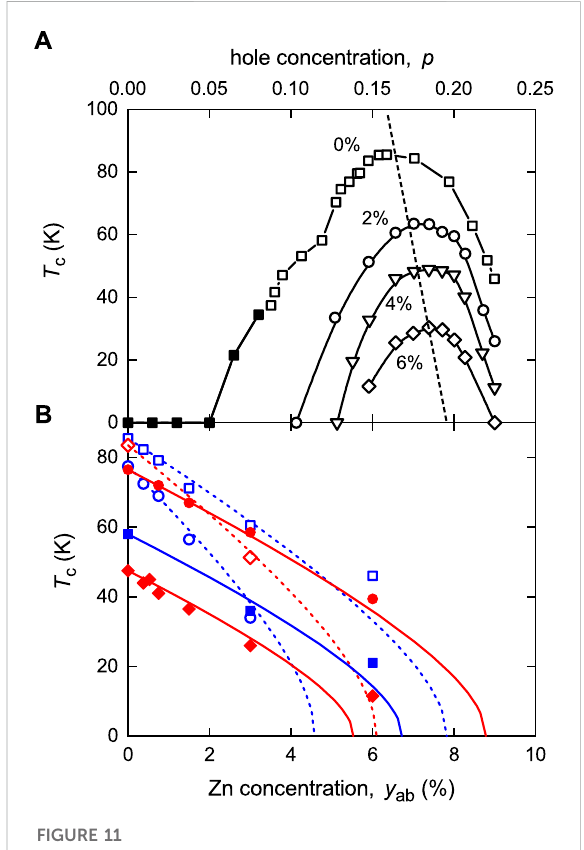
FIGURE 11 (A) T c plotted as a function of hole concentration, p , for Zn- substituted Y 0.8 Ca 0.2 Ba 2 (Cu,Zn) 3 O 7 − δ at 4 different Zn concentrations: 0%, 2%, 4%, and 6%. The dashed line is a guide to the eye showing the asymmetric collapse of the phase curve toward p * ≈ 0.19. (B) Datapointsshow T c asafunctionofplanarZn concentration, y ab for fi xed doping states. Open symbols are under-doped and fi lled are over-doped. For ease of identi fi cation, colors alternateblue, thenred,andthenblueagainwithincreasing doping. The lines are T c vs y ab calculated using Eq. 8. Dashed curves are under-doped, and solid curves,